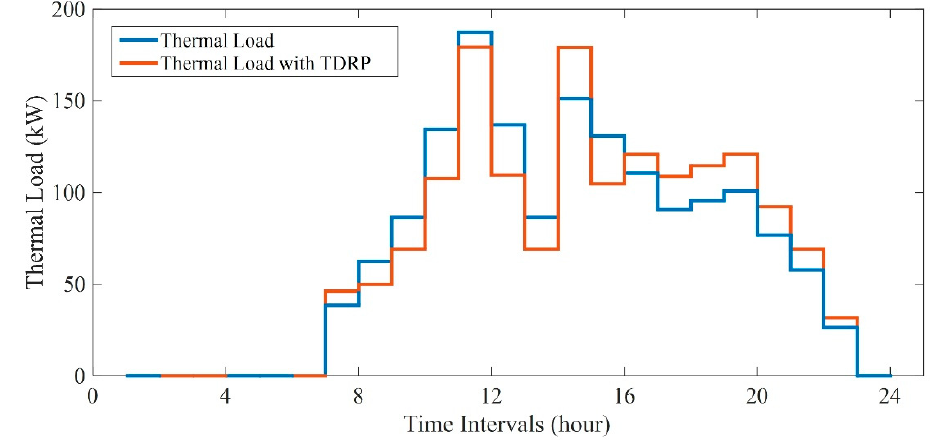
Figure 4. Thermal load with/without thermal demand response program (TDRP) on the typical winter day.